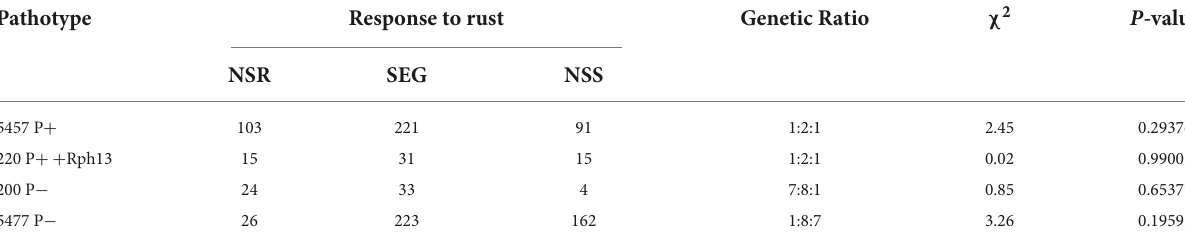
TABLE 3 The inheritance of resistance to four pathotypes of Puccinia hordei in barley line GID 5779743 using F 2 -derived F 3 families from the cross GID/Gus. Pathotype